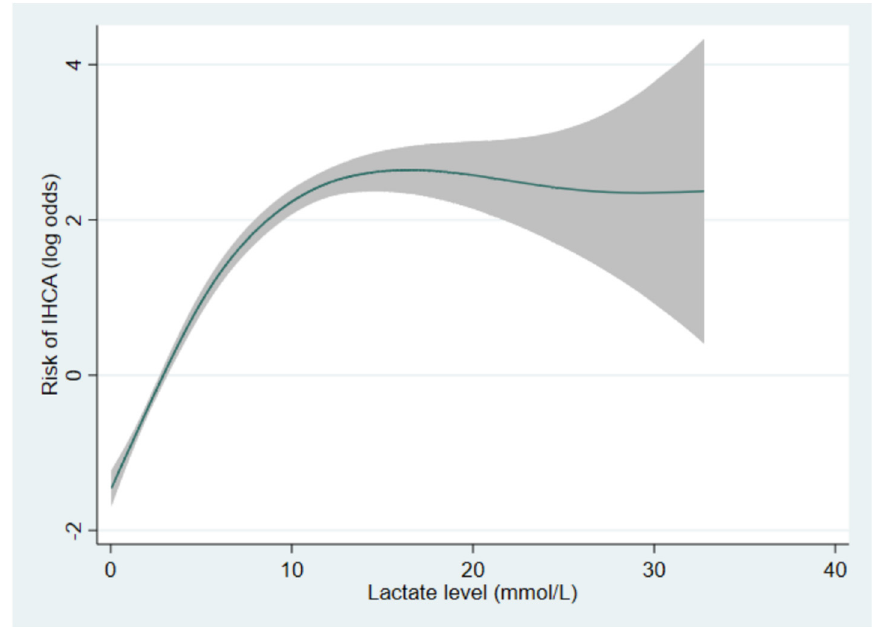
Figure 2. The generalised additive model showing the dose–response relationship between lactate levels and the risk of IHCA. The shaded area represents 95% confidence intervals. A log odds of zero represents the reference.